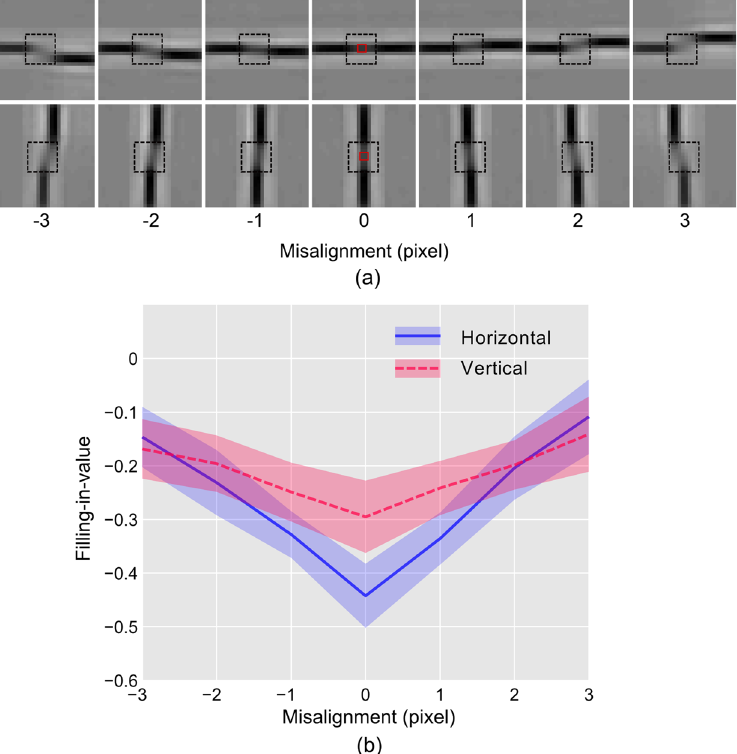
Figure 5. Anisotropy of tolerance in filing-in for misaligned bar. ( a ) Perceptually equivalent images are shown, which are generated from the response of PE neurons while the network was stimulated with stimuli depicted in Fig. 3b. ( b ) The plots of ‘filling-in-value’ in BS area of the images in ( a ) as a function of misalignment between the bars are shown. Convention for lines and the shades are as described in Fig.